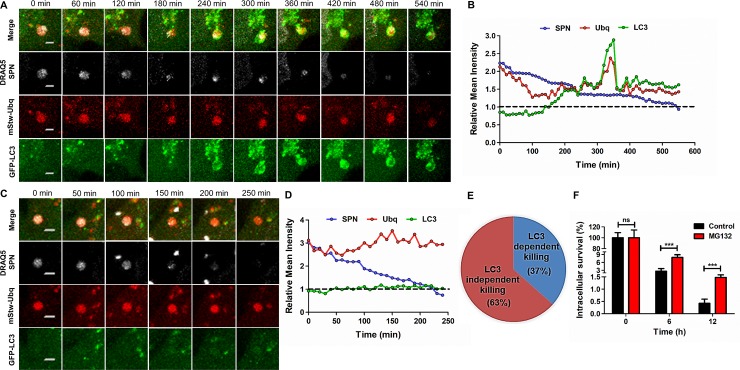
Degradation of cytosolic SPN via autophagy–dependent or independent pathway is reliant on Ply induced ubiquitination.A, C. Representative time-lapse montage for degradation of cytosolic SPN following escape from autophagosomes in LC3-dependent (A) or independent manner (C). hBMECs stably expressing LC3-GFP (green) and Ubq-mStrawberry (red) were infected with DRAQ5 stained WT SPN (white). Live imaging of infected cells was performed for extended hours beginning at 6 h p.i. under a confocal microscope and time-lapse series with intervals of 60 min (A) or 50 min (C) are represented. The stills in “A” and “C” correspond to movies shown as S3 and S4 Movies, respectively. Scale bar, 2 μm. B, D. Temporal quantification of ubiquitin, LC3 and SPN fluorescence intensities either relative to fluorescence in the cytosol (Cyt) (for LC3 and Ubq) or fluorescence signal of hBMEC nuclei (Nuc) (for SPN). Relative mean intensity for LC3 (IPCV/ICyt) in case of ubiquitinated SPN displayed values > 1.0, depicting LC3-dependent killing of SPN (B). Ubiquitinated SPN that is degraded in LC3 independent manner, displayed relative mean intensity value ~ 1.0 for LC3 (D). In both cases relative mean intensity values for bacteria (ISPN/INuc) remains > 1.0 for substantially long period of time before finally disappearing. E. Percentage of ubiquitinated SPN undergone LC3-dependent or independent killing as examined by time-lapse imaging of hBMECs stably expressing GFP-LC3 and Ubq-mStrawberry following infection with DRAQ5 stained SPN. n = 41. F. Intracellular survival percentages of WT SPN following treatment with MG132 (10 μM) at indicated time points relative to 0 h. Data are presented as mean ± SD of triplicate experiments. Statistical analysis was performed using two-way ANOVA (Bonferroni test). ns, non-significant, ***p<0.001.